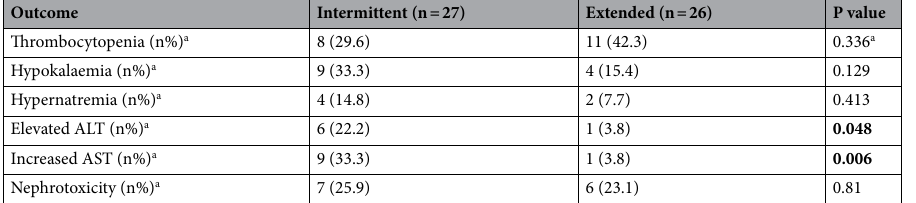
Table 4. Adverse events in both groups. a Chi-square Test. ALT alanine aminotransferase, AST aspartate aminotransferase. Thrombocytopenia (Platelets < 150 *10 9 L), Hypokalaemia (Potassium < 3.5 mEq/L), Hypernatremia (Sodium > 145 mEq/L), Increased ALT and AST (> double baseline value). Nephrotoxicity was defined based on Kidney Disease: Improving Global Outcomes (KDIGO) and the Acute Kidney Injury Network (AKIN) i.e. A threshold increment of > 0.3 mg/dL in S.cr over 48-h 21 . P-value ≤ 0.05 is considered statistically significant. Significant P-values are in